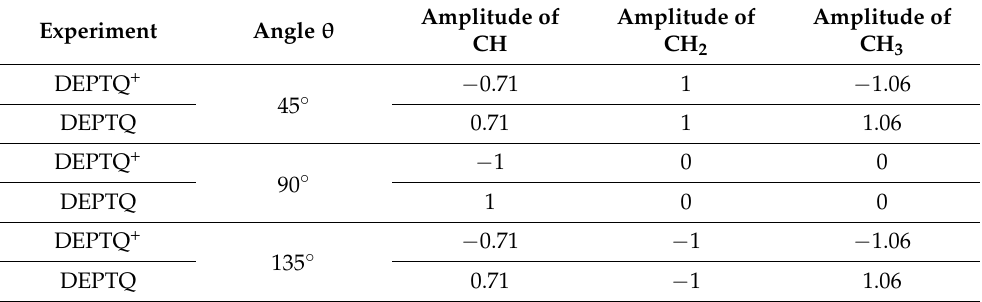
Table 2. DEPTQ and DEPTQ + : maximal amplitude of CH, CH 2 , and CH 3 groups for the three usual angles θ and for Ω = 90 ◦